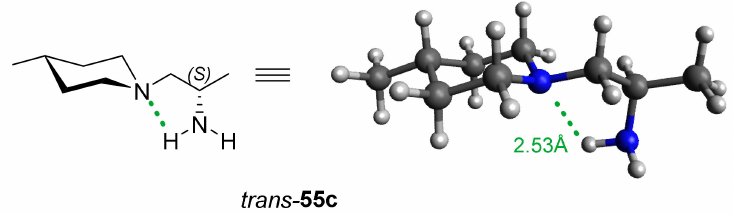
Figure 14. Stabilization of trans- 55c by H-bond